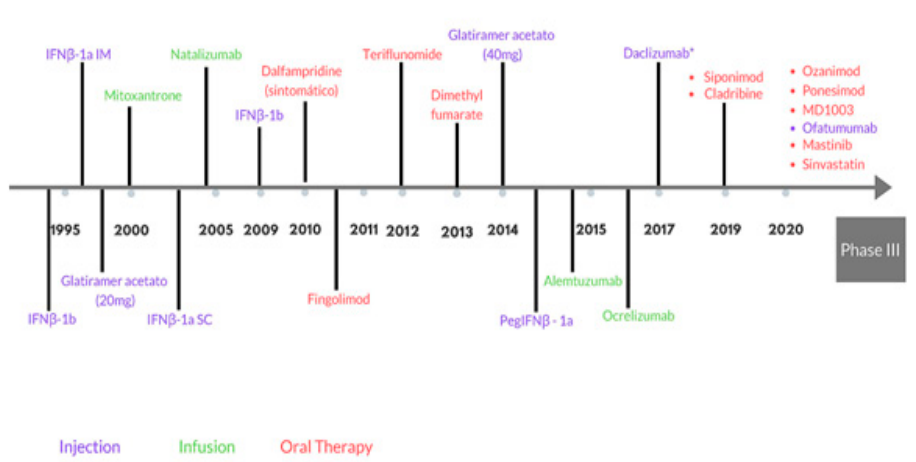
Figure 4. The Evolving multiple sclerosis (MS) Treatment Landscape.